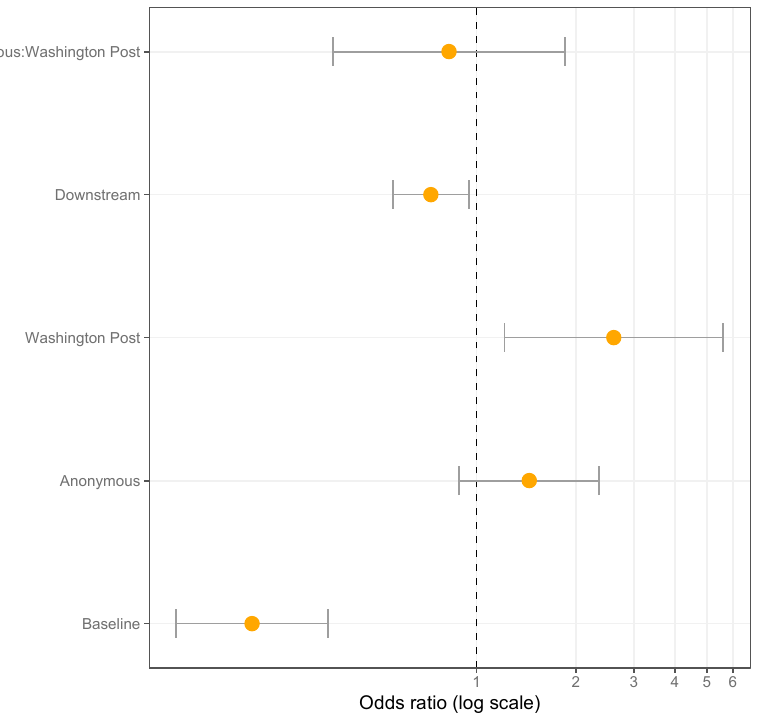
Figure 2. Odds ratio for the fixed factors. Baseline is New York Times, signed, original comments. From Table 3 the baseline is about 18% toxic comments, which is congruent with model estimates ((20.8 ± 1.3)%). Odds ratio of 1 means no change. Table 3. Number of toxic comments coded as interpersonal, other-directed and neutral.